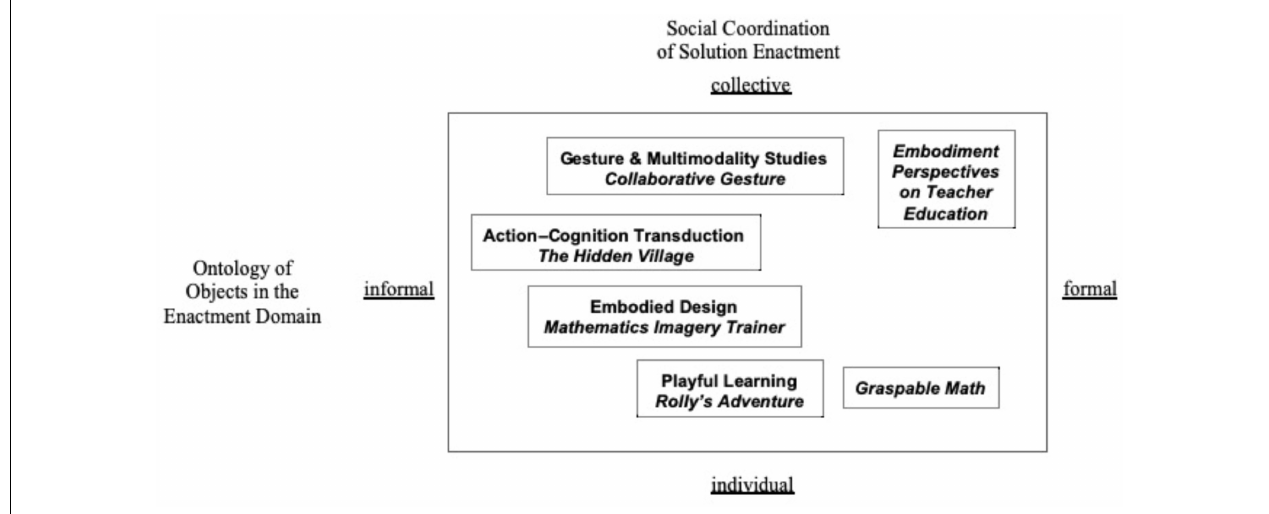
FIGURE 11 | Plotting the six embodied designs along two axes: ( x ) the manipulatives’ ontological status; and ( y ) the social participation of solution